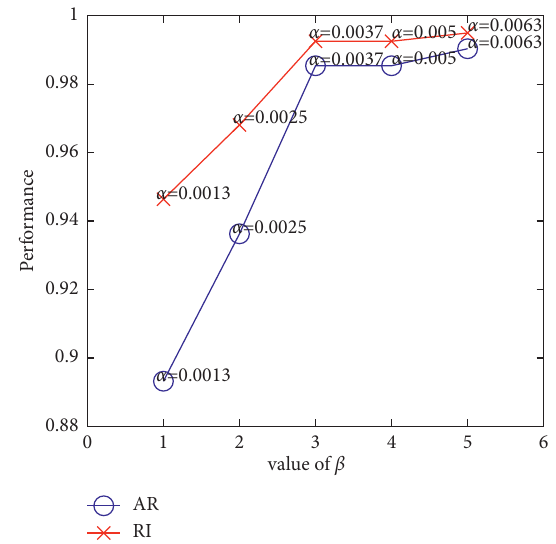
Figure 11: Relations of the parameter and performance of the proposed